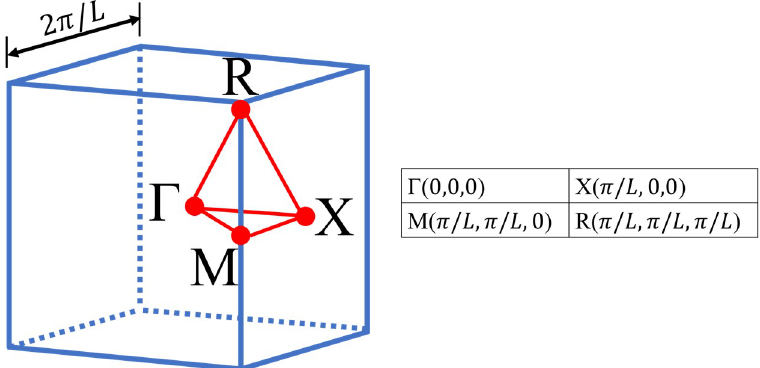
Figure 7. The IBZ of a cubic lattice with the reciprocal space coordinates of the critical points.